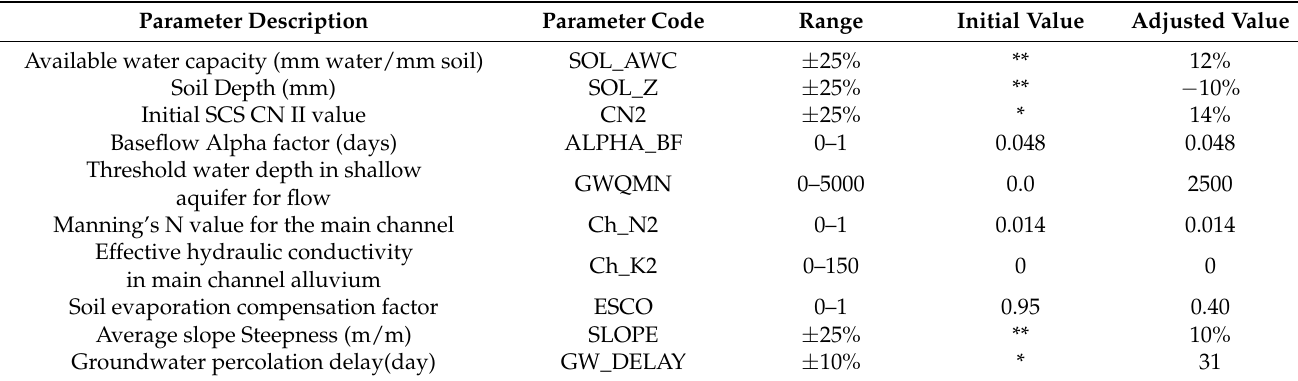
Table 3. Initial and final calibrated flow parameter values.